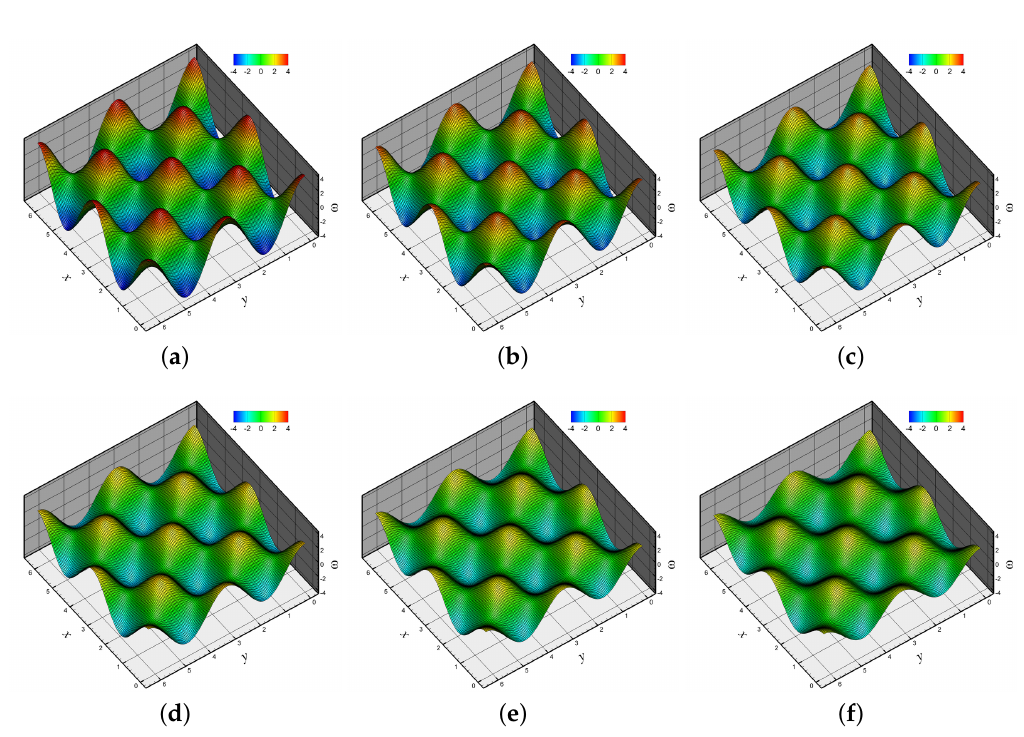
Figure 6. Evolution of the vorticity field for the Taylor-Green vortex (TGV) decaying problem for κ =